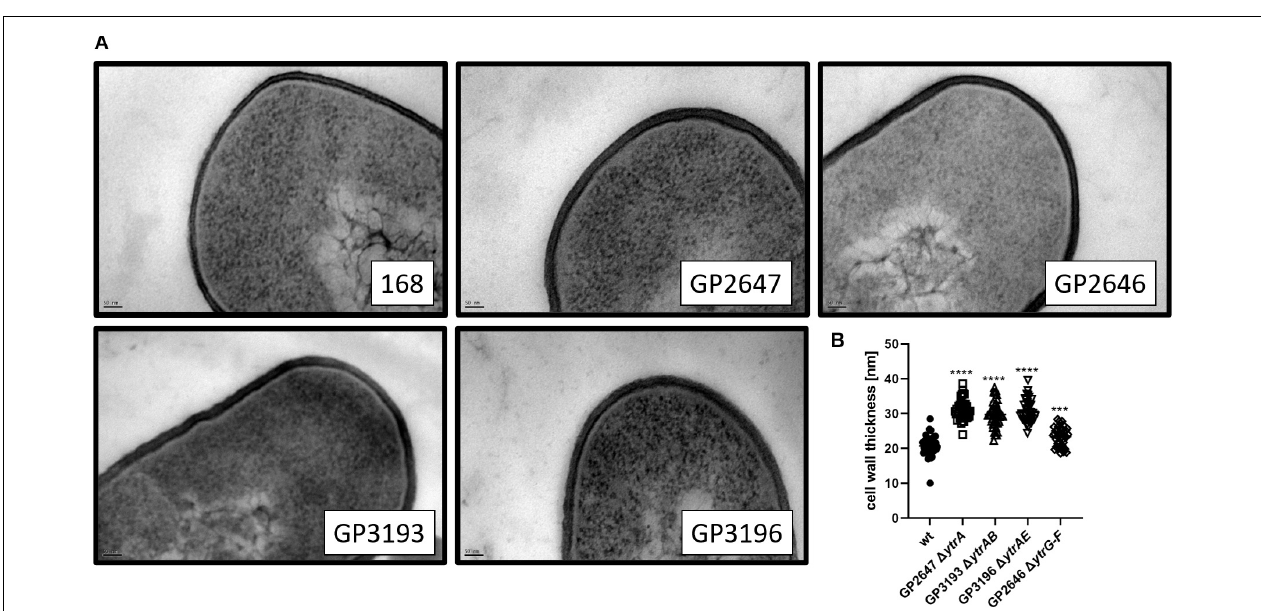
FIGURE 4 | Cell wall thickness is increased in ytrA , ytrAB , and ytrAE mutants. (A) Shown are representative transmission electron microscopy images of the wild type strain 168, the ytrA mutant (GP2647), the ytrAB (GP3193), and the ytrAE (GP3196) double mutants and the ytrGABCDEF mutant (GP2646). Scale bar is 50 nm. (B) Cell wall thickness of B. subtilis wild type and ytr mutants. The cell wall thickness of 40 individual cells per strain was measured as described in section “Materials and Methods”and plotted. For statistical analysis, a one-way ANOVA followed by a Dunnett’s comparison test was used (*** p ≤ 0.001 and **** p ≤